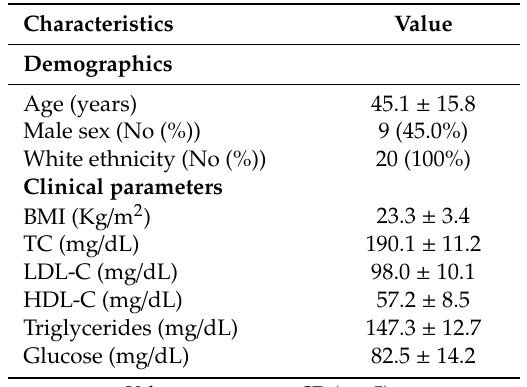
Table 3. Baseline characteristics of randomised